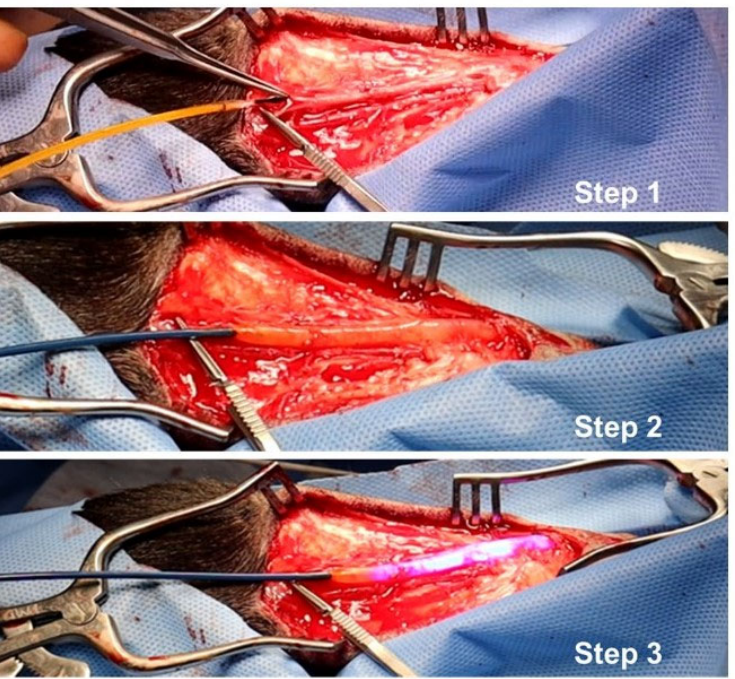
Figure 9. Photographic Depiction of the VRS-AVF Treatment Steps during Sheep Fistula Creation Surgery. Step 1 (Upper Panel): The device coated with the 10-8-10 Dimer is introduced into the vein without fluoroscopy. Step 2 (Middle Panel): The balloon is inflated inside the vein to dilate the vein lumen. Step 3 (Lower Panel): The light treatment activates the drug in the venous wall creating covalent linkage of the extracellular matrix proteins.